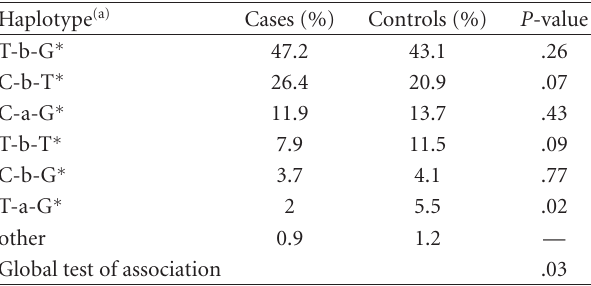
Table 5: NOS3 haplotype distribution in cases and